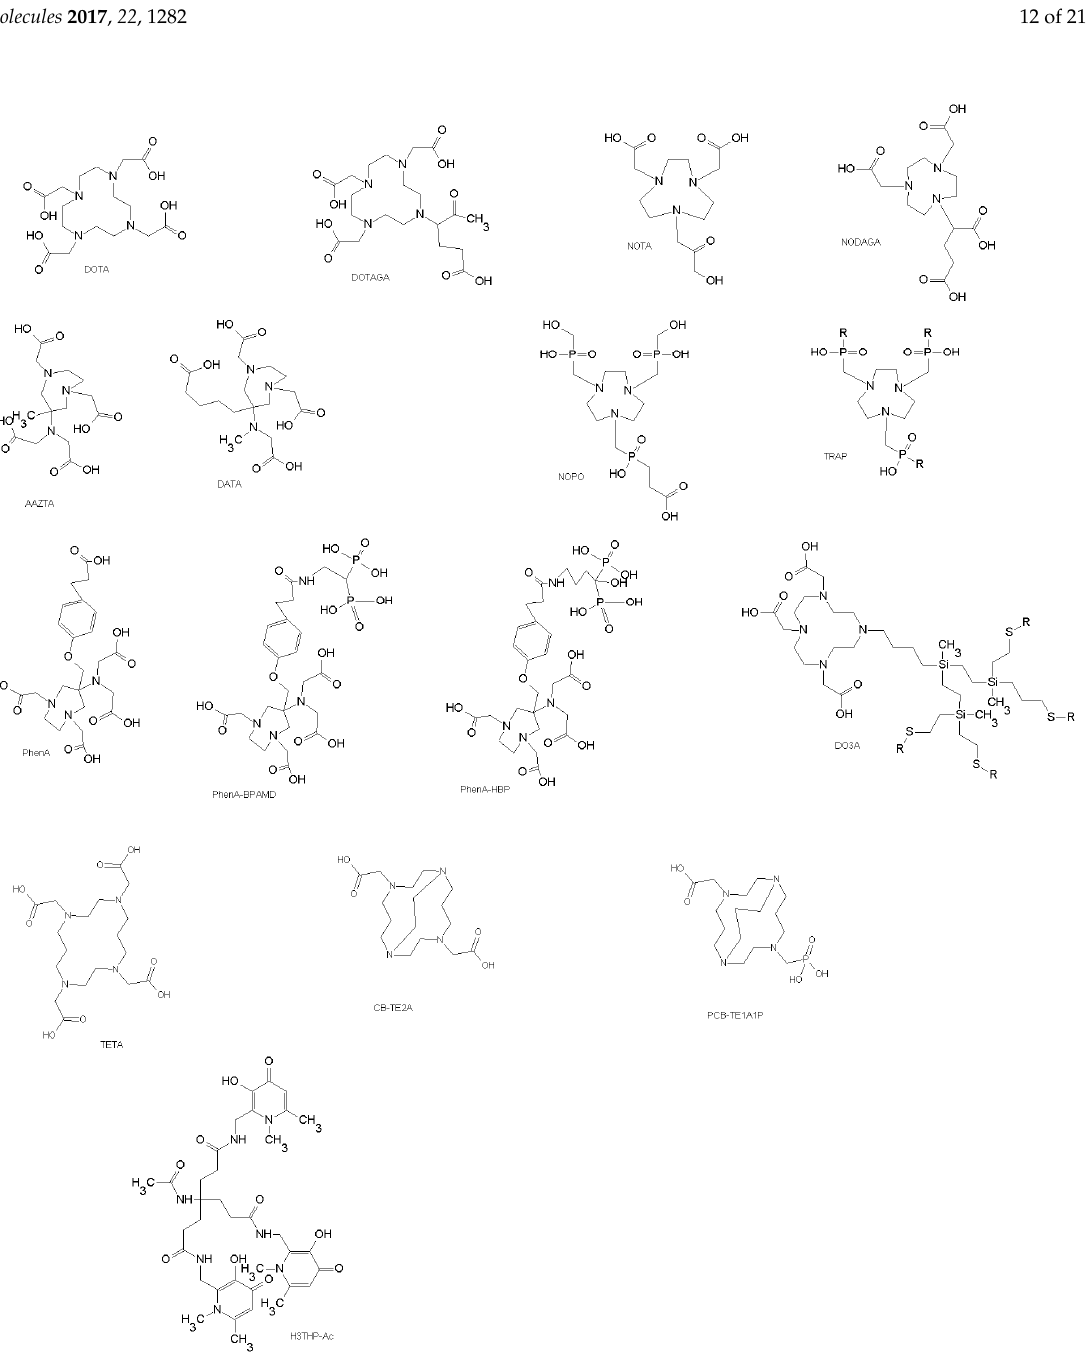
Figure 4. Chemical structures of DOTA chelators and analogues.